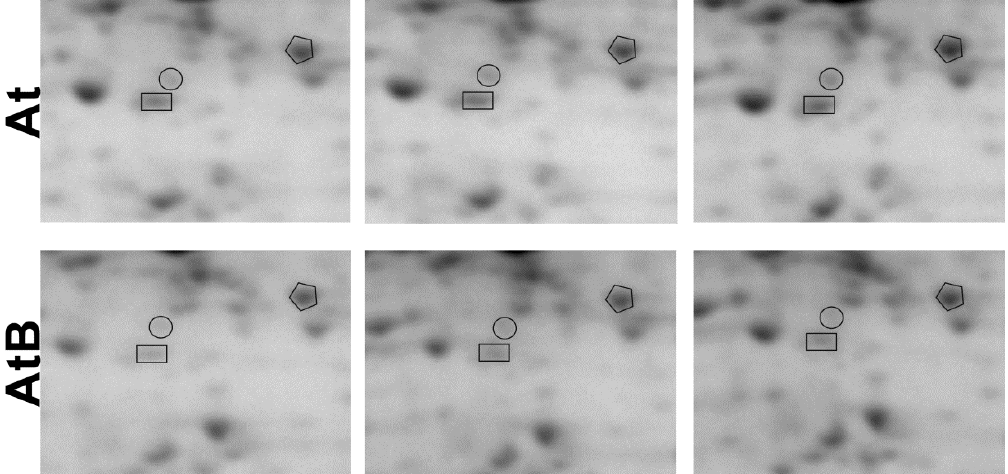
Figure 2. Downregulation of RACK1 proteins in rolB -expressing Arabidopsis plants. Gels were scanned using a VersaDoc MP 4000 system with PDQuest 8.0.1 Advanced software as described in Section 4.3. Protein expression is presented as the average total spot intensity in a group of three repeated gels. Fragments of 2-D gels of protein fractions from the control (At) and rolB- transformed AtB-1 line (AtB) are presented in triplicate: RACK1A, marked with polygons; RACK1B (boxes) and RACK1C (circles).